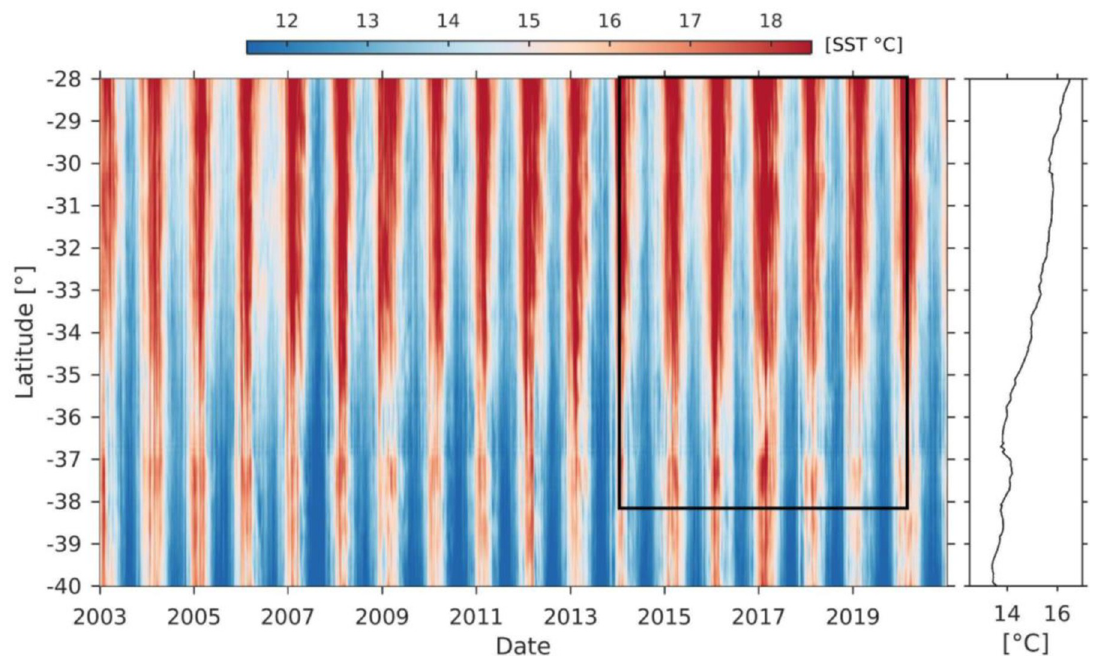
Fig 7. Hovmo¨ller diagram of coastal (first 100 nm) daily sea surface temperatures (SST) between 28˚S and 40˚S. The black box indicates the spatio-temporal scale of the crustacean demersal fishery discard data. The right panel shows the mean latitudinal variation throughout the